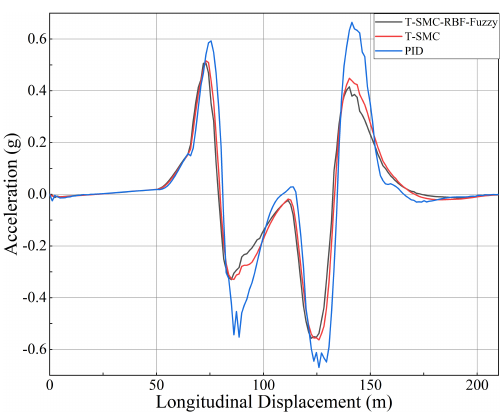
Figure 20. Yaw rate of different